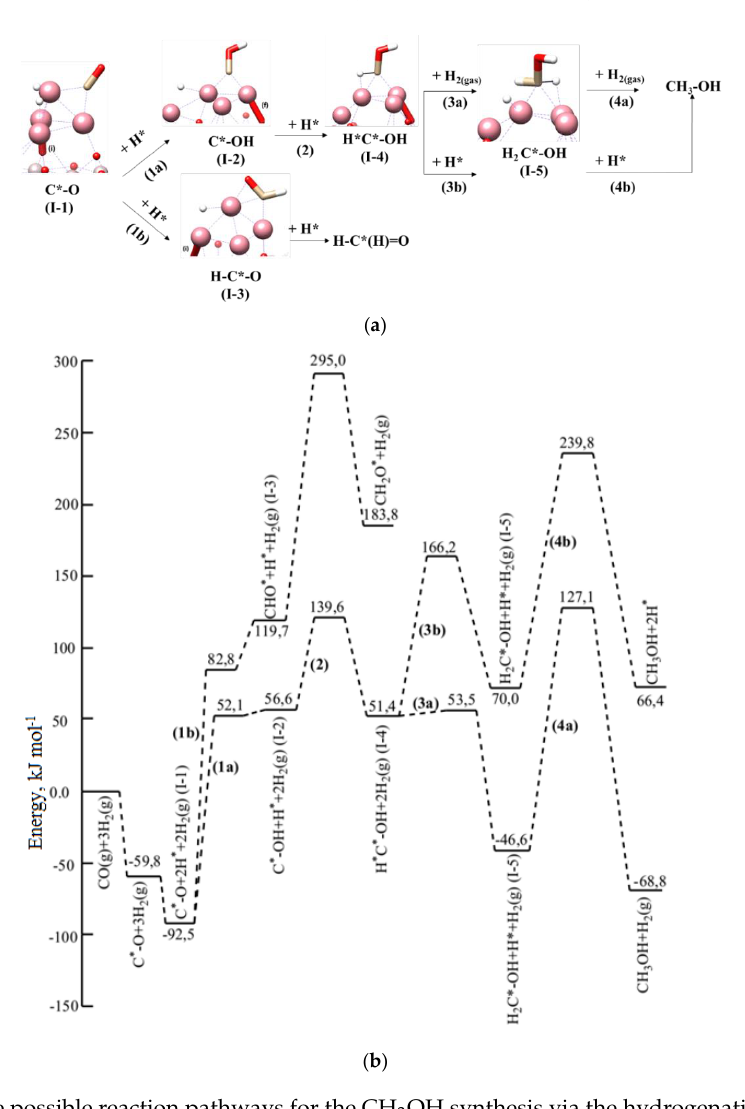
Figure 4. The possible reaction pathways for the CH 3 OH synthesis via the hydrogenation of CO on the Co 4 /Al 2 O 3 catalyst (colors: bronze—carbon atom, red—oxygen atom, white—hydrogen atoms, violet—cobalt atoms), symbol “*” denotes the adsorbed species. Potential energy diagram obtained from density functional theory (DFT) calculations for CH 3 OH synthesis via the hydrogenation of CO on the Co 4 /Al 2 O 3 catalyst, symbol “*” denotes the adsorbed